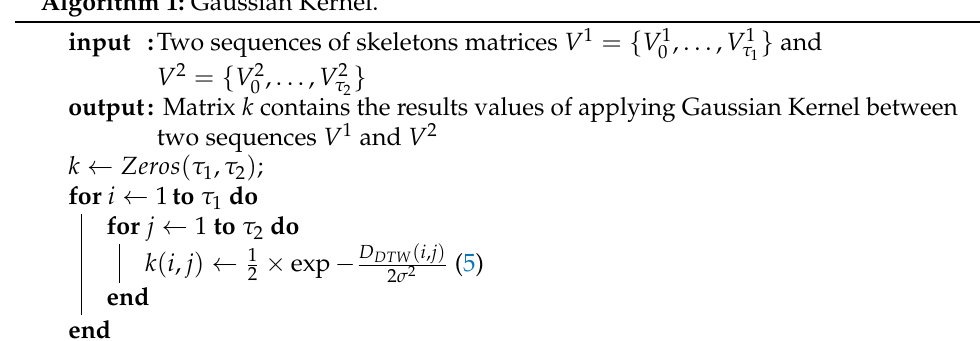
Algorithm 1: Gaussian